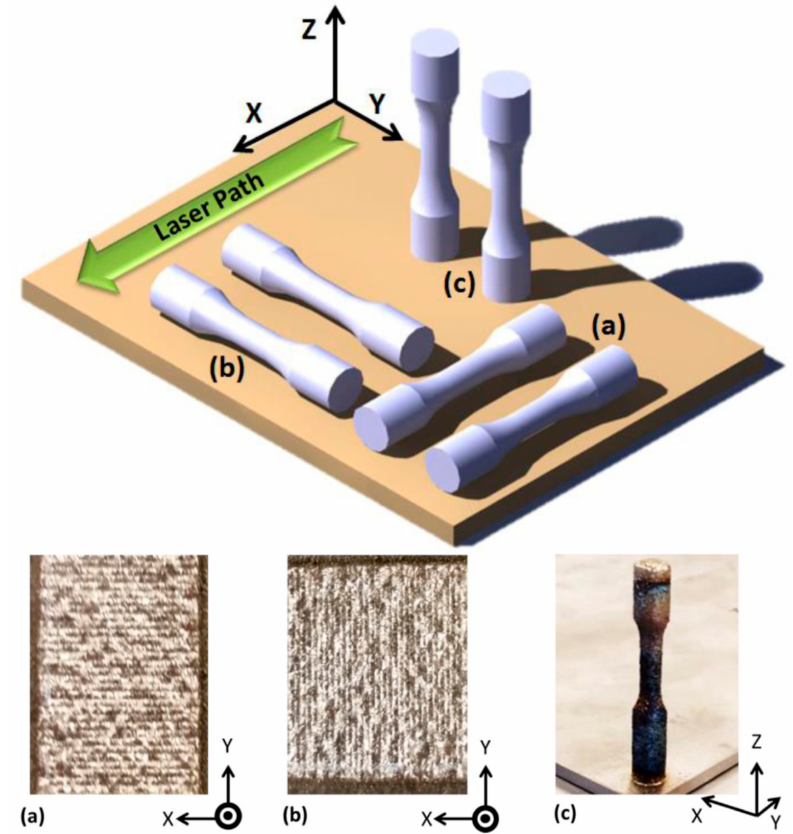
Figure 13. Schematic view of DED Ti-6Al-4V specimens, ( a ) as-deposited surface in the X-direction (horizontally oriented), ( b ) as-deposited surface in the Y-direction (laterally oriented), and ( c ) as-deposited surface in the Z-direction (vertically oriented) (reproduced with permission from [18] Copyright Elsevier,